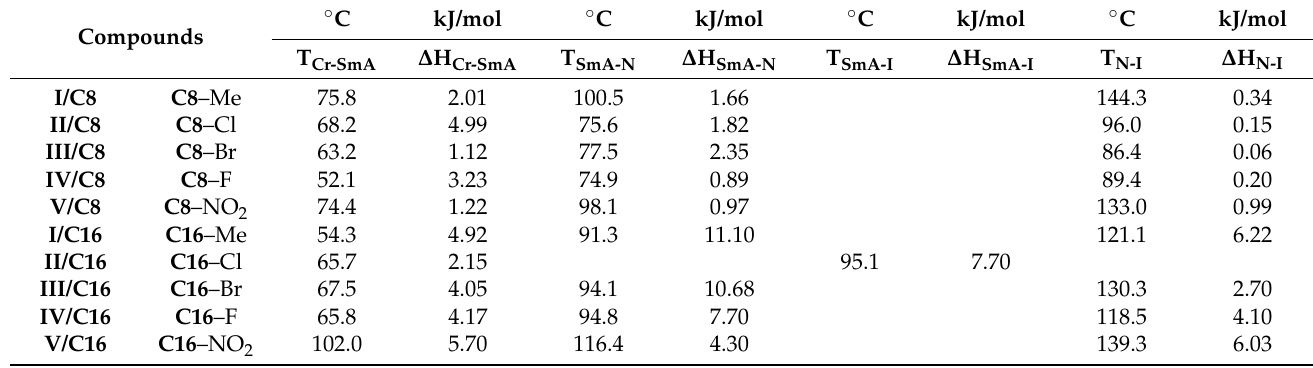
Table 1. Phase transitions: temperatures ( T , ◦ C) andenthalpies ( ∆ H , kJ/mol) for the (( I – V ) Cn ) complexes. ◦ Compounds